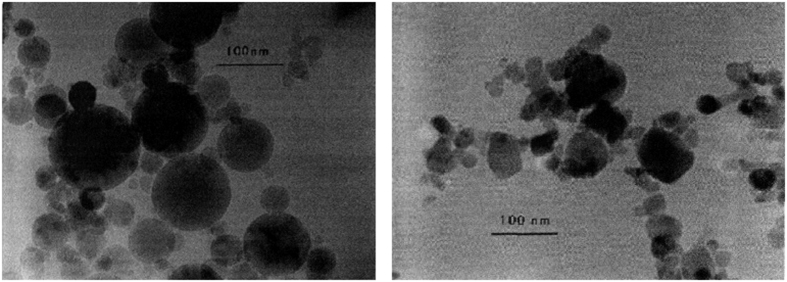
Aggregation and thermal conductivity predictions for stationary NS.Transmission electron micrographs (TEM) shows typical aggregated morphology in nanofluids: Al2O3/water (r = 19.2 nm, Left) and CuO/water (r = 11.8 nm, Right)13.